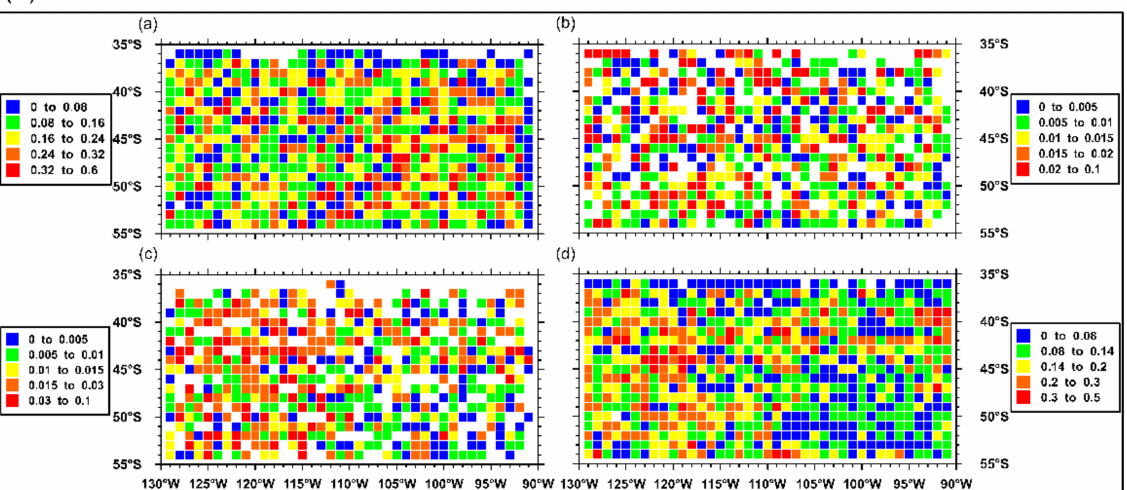
Figure 11. Density distribution of four matching situations in the three regions: ( A ) the South-China Sea; ( B ) the North-West Pacific; ( C ) the South-East Pacific and ( a ) Situation A; ( b ) Situation B; ( c ) Situation C; ( d ) Situation D. The legends show the range of density